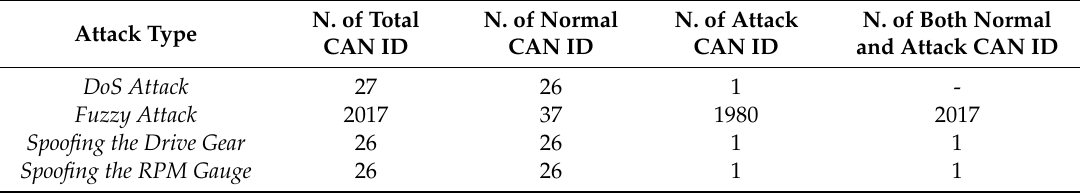
Table 4. Number of CAN ID identifiers (total, normal and attack) in each dataset. Attack